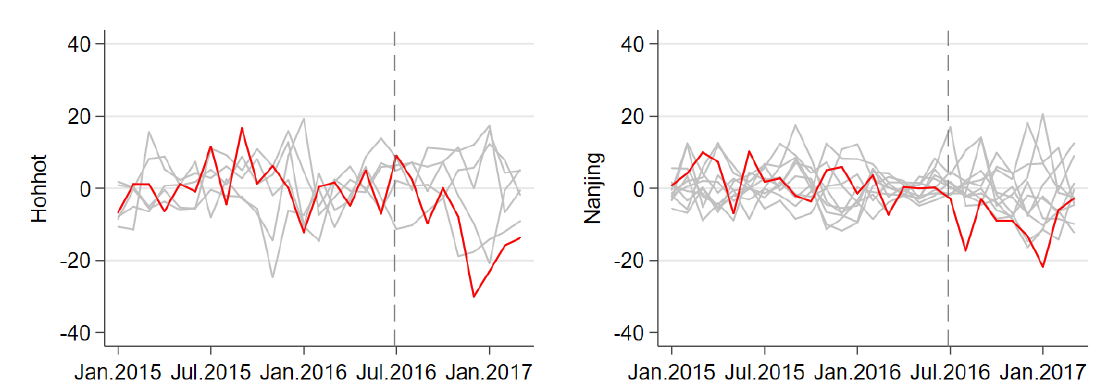
Figure 3. Gap distribution in permutation